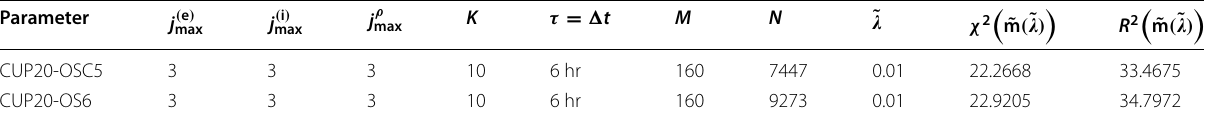
Table 2 The input settings, and the diagnostics outputs (regularization parameter, data misfit, and regularization value) of the 3-D runs presented in this paper